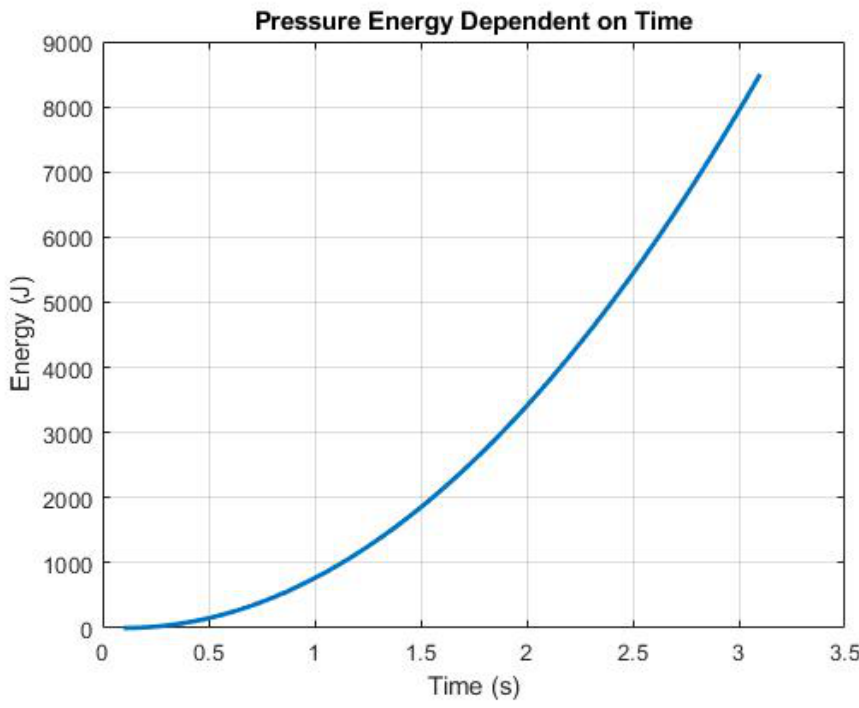
Figure 7. Energy input from pressure source defined by the constant change in